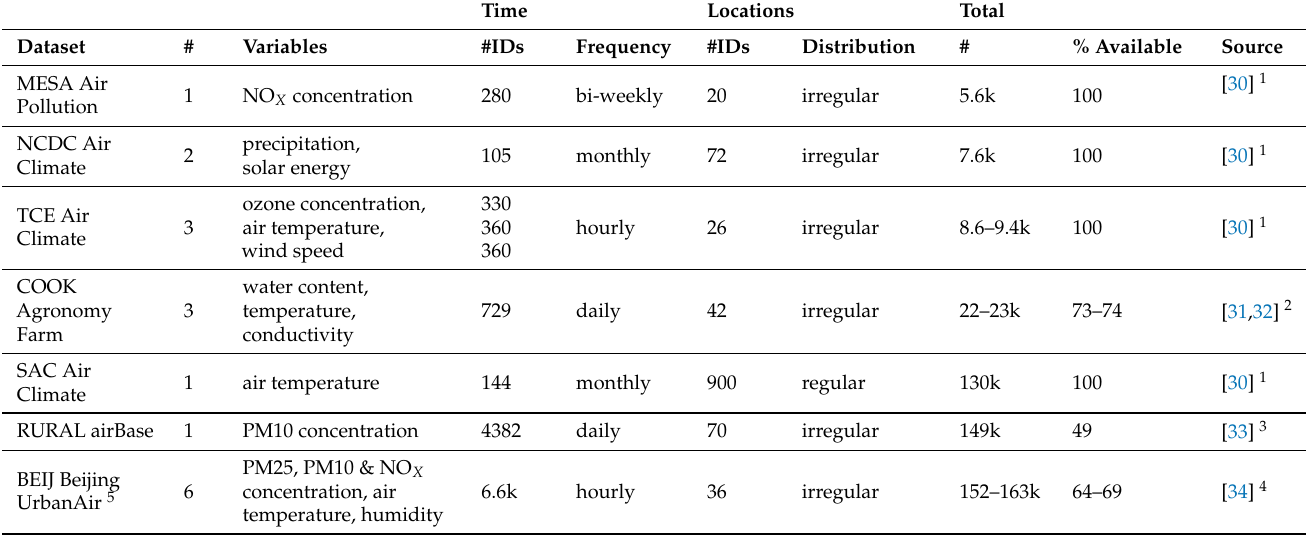
Figure 7. Global distribution of locations included in each data source. Table 2. Description of real-world datasets, including the total number of observations that are available, and the percentage of all possible combinations of location and time-stamp that they